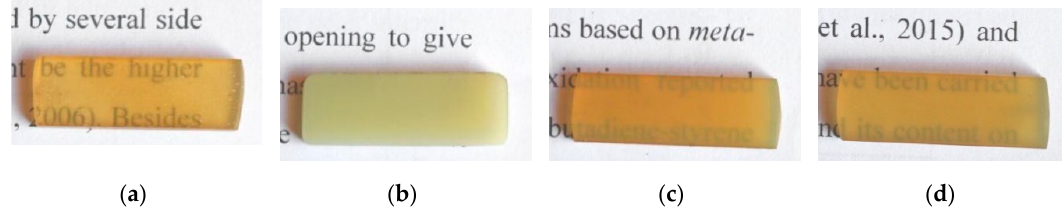
Figure 4. Photographs showing the different levels of optical transparency of EP/eKraton blends containing 10 wt.% of eKraton of different irradiation doses in the visible light range (400–700 nm). ( a ) Pure epoxy (EP); ( b ) eKraton; ( c ) eKraton-20; ( d ) eKraton-50 (the width of the sample is 10 mm in each case).